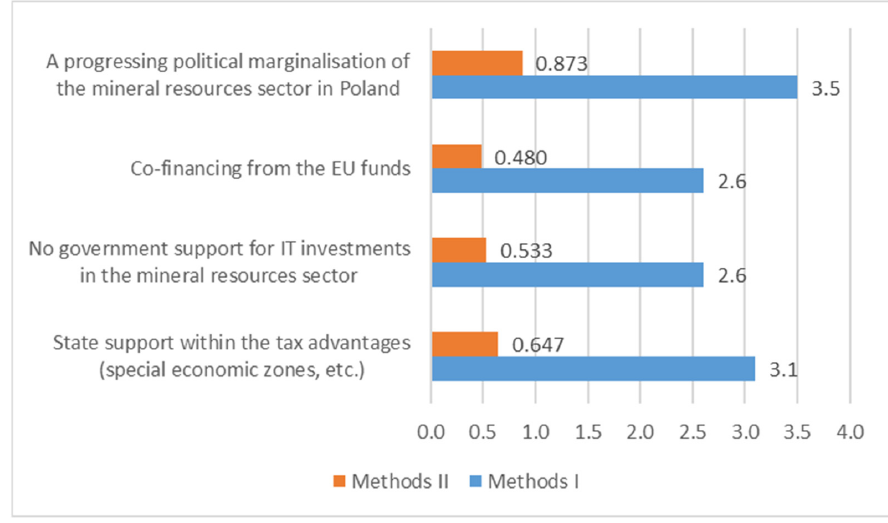
Figure 7. Summary of the results for the political factors from both methods. Authors’ own study.